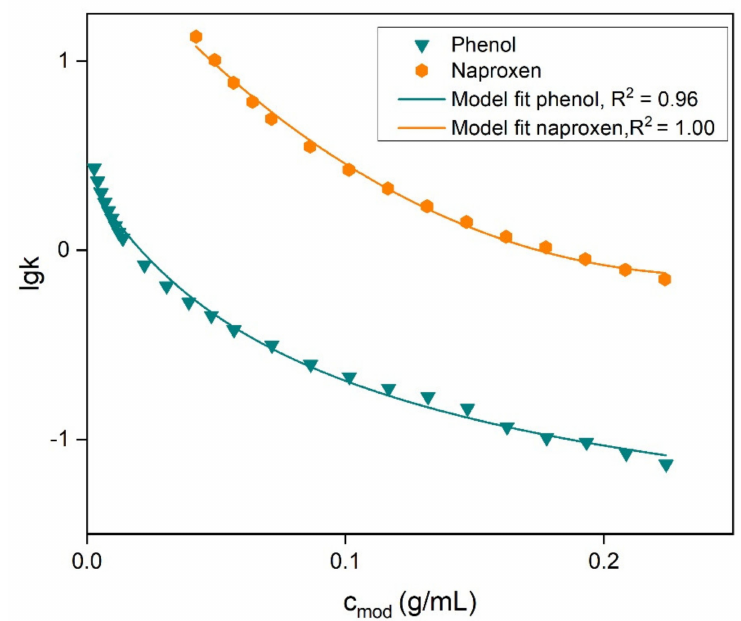
Figure 4. Retention factors of phenol and naproxen on SIL-Aerogel and model fittings according to